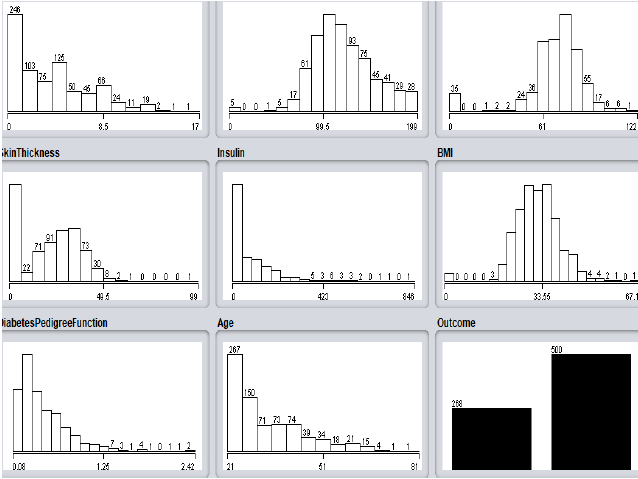
Figure 5. Distribution of PIDD Attributes